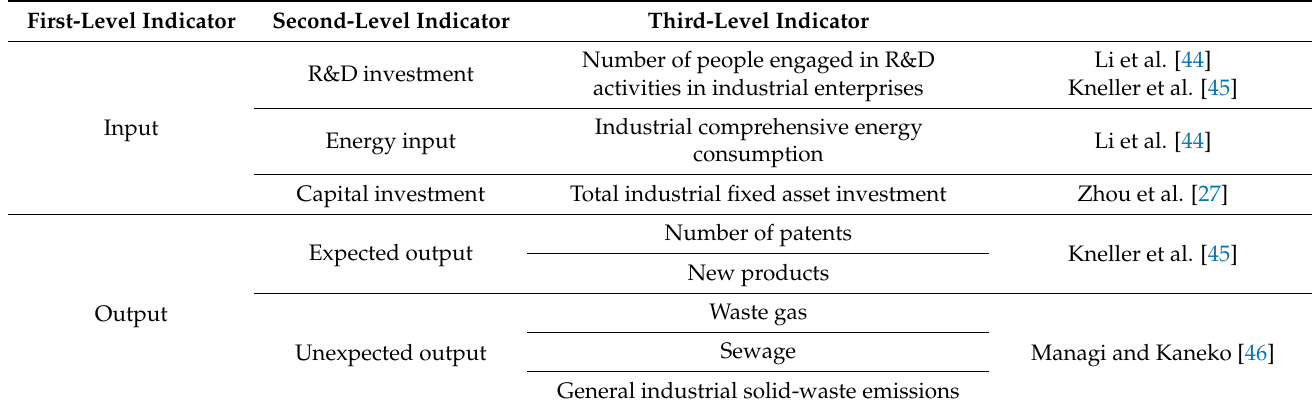
Table 1. Evaluation index system of green innovation efficiency in the Yangtze River